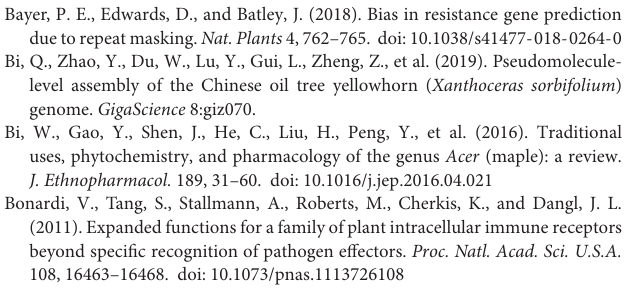
FIGURE S1 | Phylogenetic relationship of X. sorbifolium , A. yangbiense , and D. longan. Time of divergence: million years ago (MYA) (Koenen et al., 2015; Liu et al., 2015; Lin et al., 2017; Bi et al., 2019; Yang et al., 2019). FIGURE S2 | Details of the amino acid frequencies of the whole NBS domain of CNL, TNL, and RNL genes in the three Sapindaceae species (WebLogo). FIGURE S3 | The chromosomal distribution of identified NBS-encoding genes in the X. sorbifolium genome. FIGURE S4 | The chromosomal distribution of identified NBS-encoding genes in the A. yangbiense genome. FIGURE S5 | The detailed ML tree of the NBS-encoding genes. Sequence names and supporting values are presented on all of the nodes. The tree was reconstructed based on the amino acids of the NBS domain of the NBS-encoding genes in X. sorbifolium , A. yangbiense , and D. longan using NBS-encoding genes in the A. thaliana genome were used as a reference. FIGURE S6 | The reconciled NBS-encoding gene tree with real species phylogeny and restored various duplication/loss events. “n4” indicates a loss event that occurred in the common ancestor of X. sorbifolium , A. yangbiense , and D. longan . “n2” indicates a loss event that occurred in the common ancestor of A. yangbiense and D. longan. TABLE S1 | A list of NBS-encoding genes identified from the three Sapindaceae genomes. TABLE S2 | Detailed information of the synteny NBS-encoding genes in three Sapindaceae